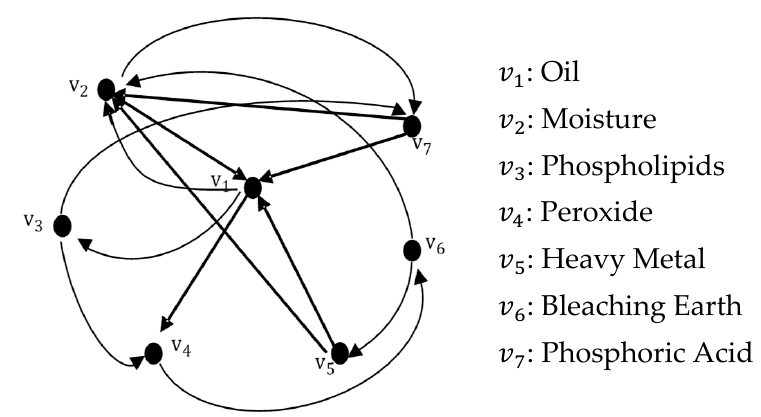
Figure 8. Graph G p . Figure 8. Graph 𝐺 (cid:3043) . Table 5. The edges for graph G p